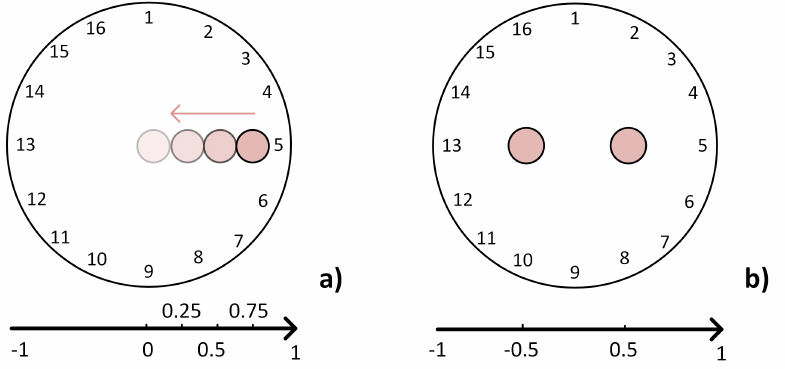
Figure 6. In ( a ), the experiments are conducted with the load applied each time step at x = 0.75, x = 0.5, x = 0.25 and finally at x = 0. The last experiment in ( b ) is the simultaneous two-point pressure at locations x1 = − 0.5 and x2 = 0.5.